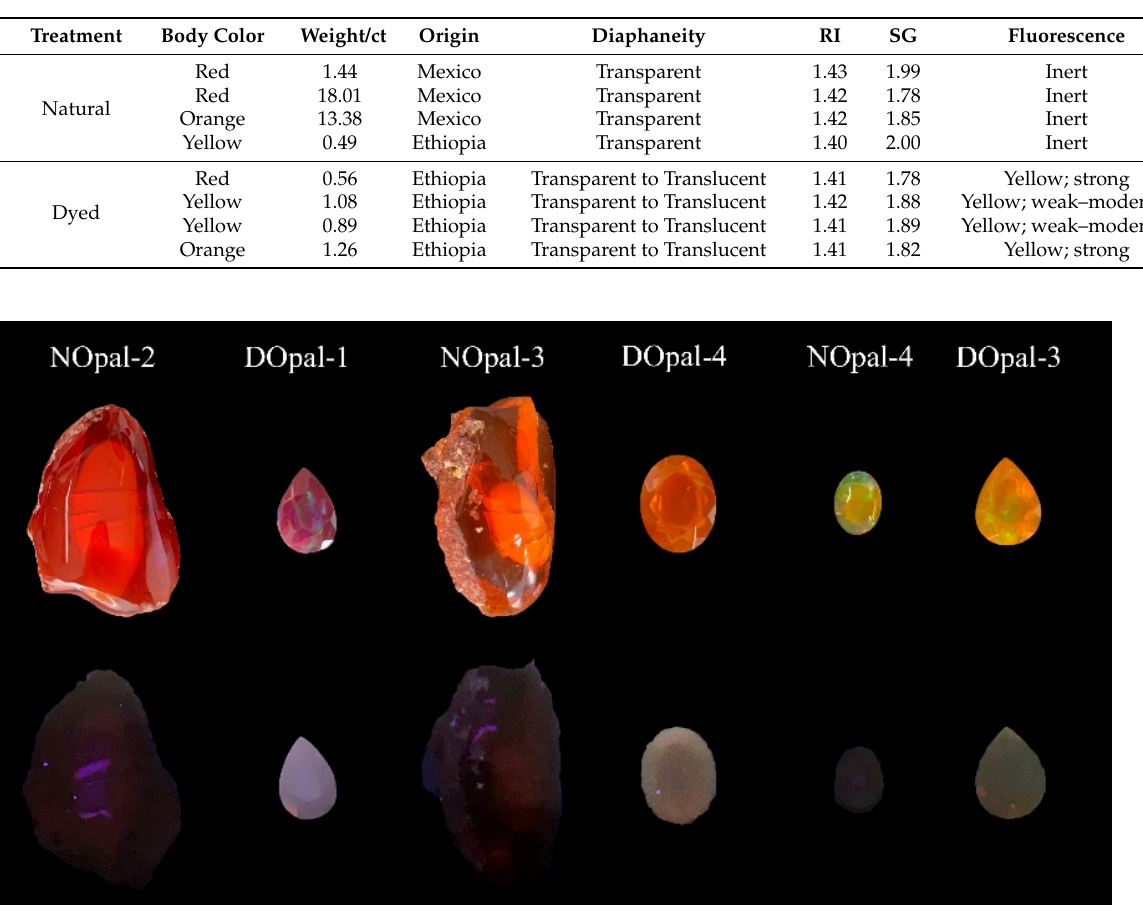
Figure 2. Natural and dyed fire opal under natural light (up) and long-wave UV light (down). From left to right: natural and dyed red fire opal, natural and dyed orange fire opal, natural and dyed yellow fire opal. Natural samples showed no response to the long-wave UV light, while dyed samples showed weak to strong fluorescence.